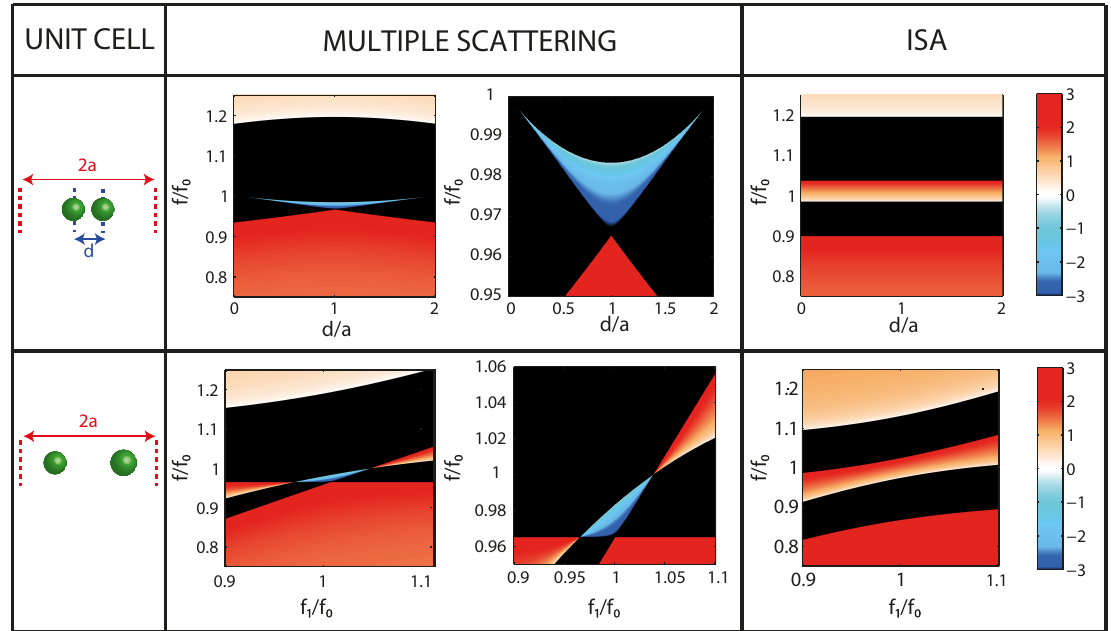
Figure 9. Either for the biperiodic (top) or the bidisperse (bottom) chains, we extracted the effective index of refraction for various strength of the symmetry breaking with a full multiple scattering approach or with the independent scattering approximation (ISA). While the maps with the full multiple scattering calculation show the existence of the negative band (blue color in the map) the ISA does not retrieve